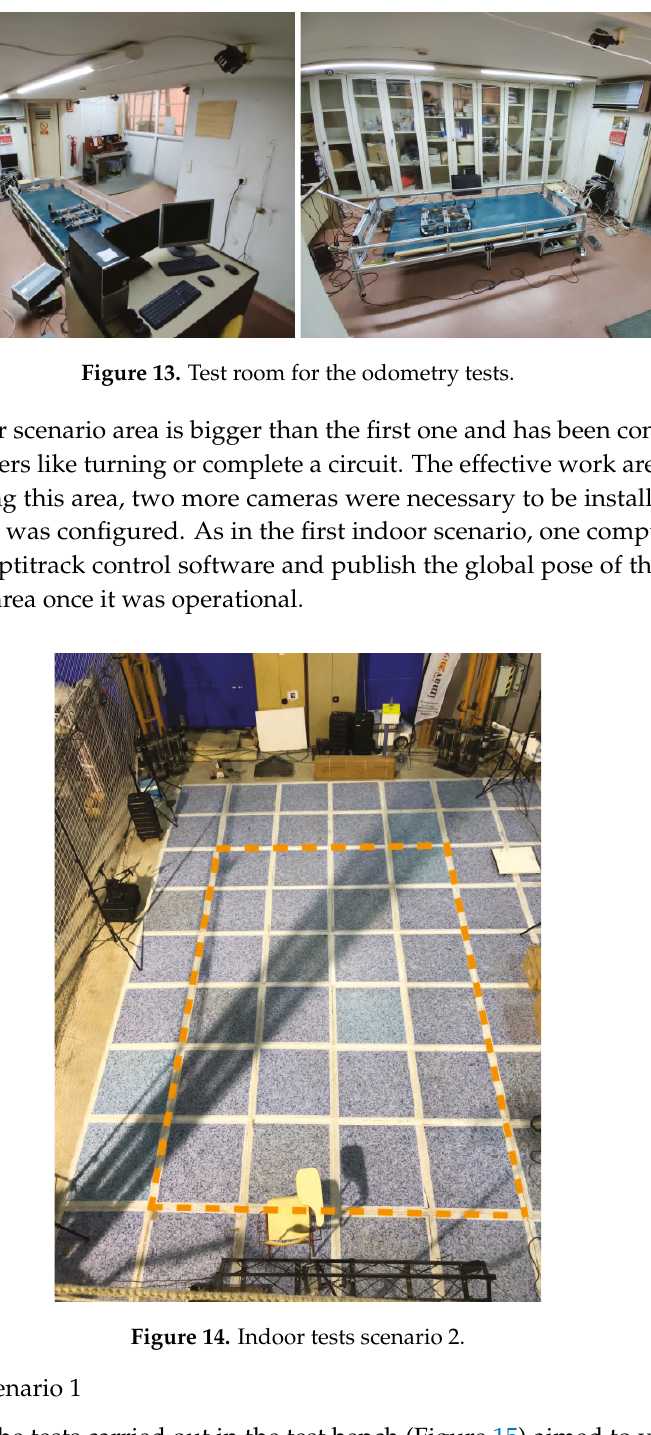
Figure 14. Indoor tests scenario 2.